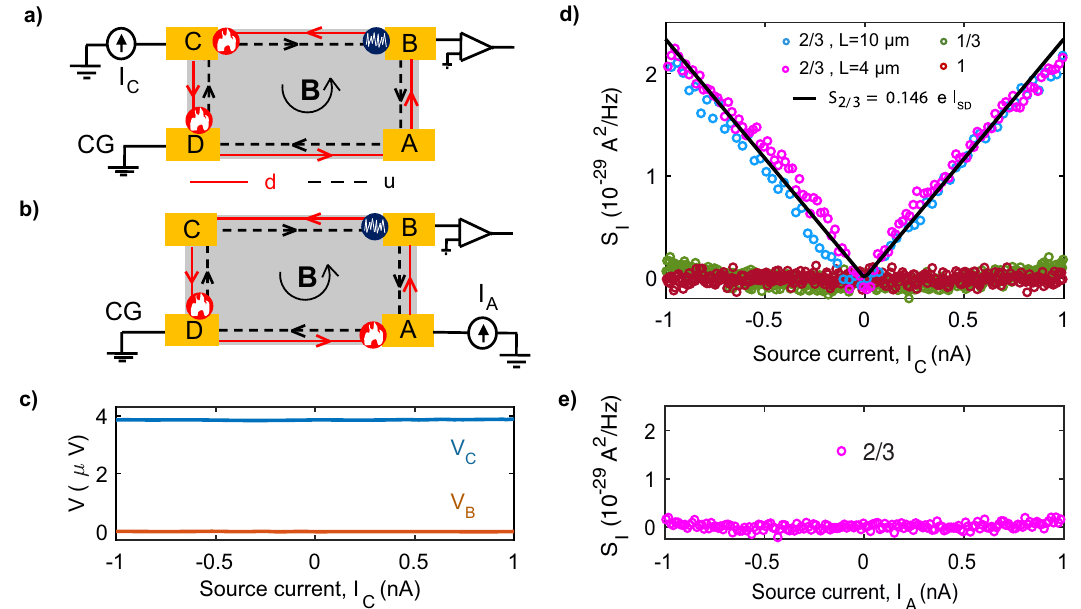
Fig. 2 Noise data. a and b show the noise detection scheme of the device-1 while the current is injected at contact C and contact A, respectively. c Differential bias response of ν = 2/3 state, where a 100 pA AC signal on top of the DC bias current is injected at contact C and the voltages are measured at contact C ( V C ) and B ( V B ) using Lock-In ampli fi er. d Noise measured along the upstream direction for longer length (10 μ m) as shown in Fig. 2a for ν = 1 (brown circles), ν = 1/3 (olive circles) and ν = 2/3 (blue circles). The magenta open circles are the measured noise along the upstream direction for shorter length (4 μ m) by reversing the magnetic fi eld (opposite chirality), and injecting current at contact A and measured noise at contact B (see SI, S5). The solid black line is the theoretically calculated noise. e Noise measured along the downstream direction for ν = 2/3 for the scheme shown in Fig.